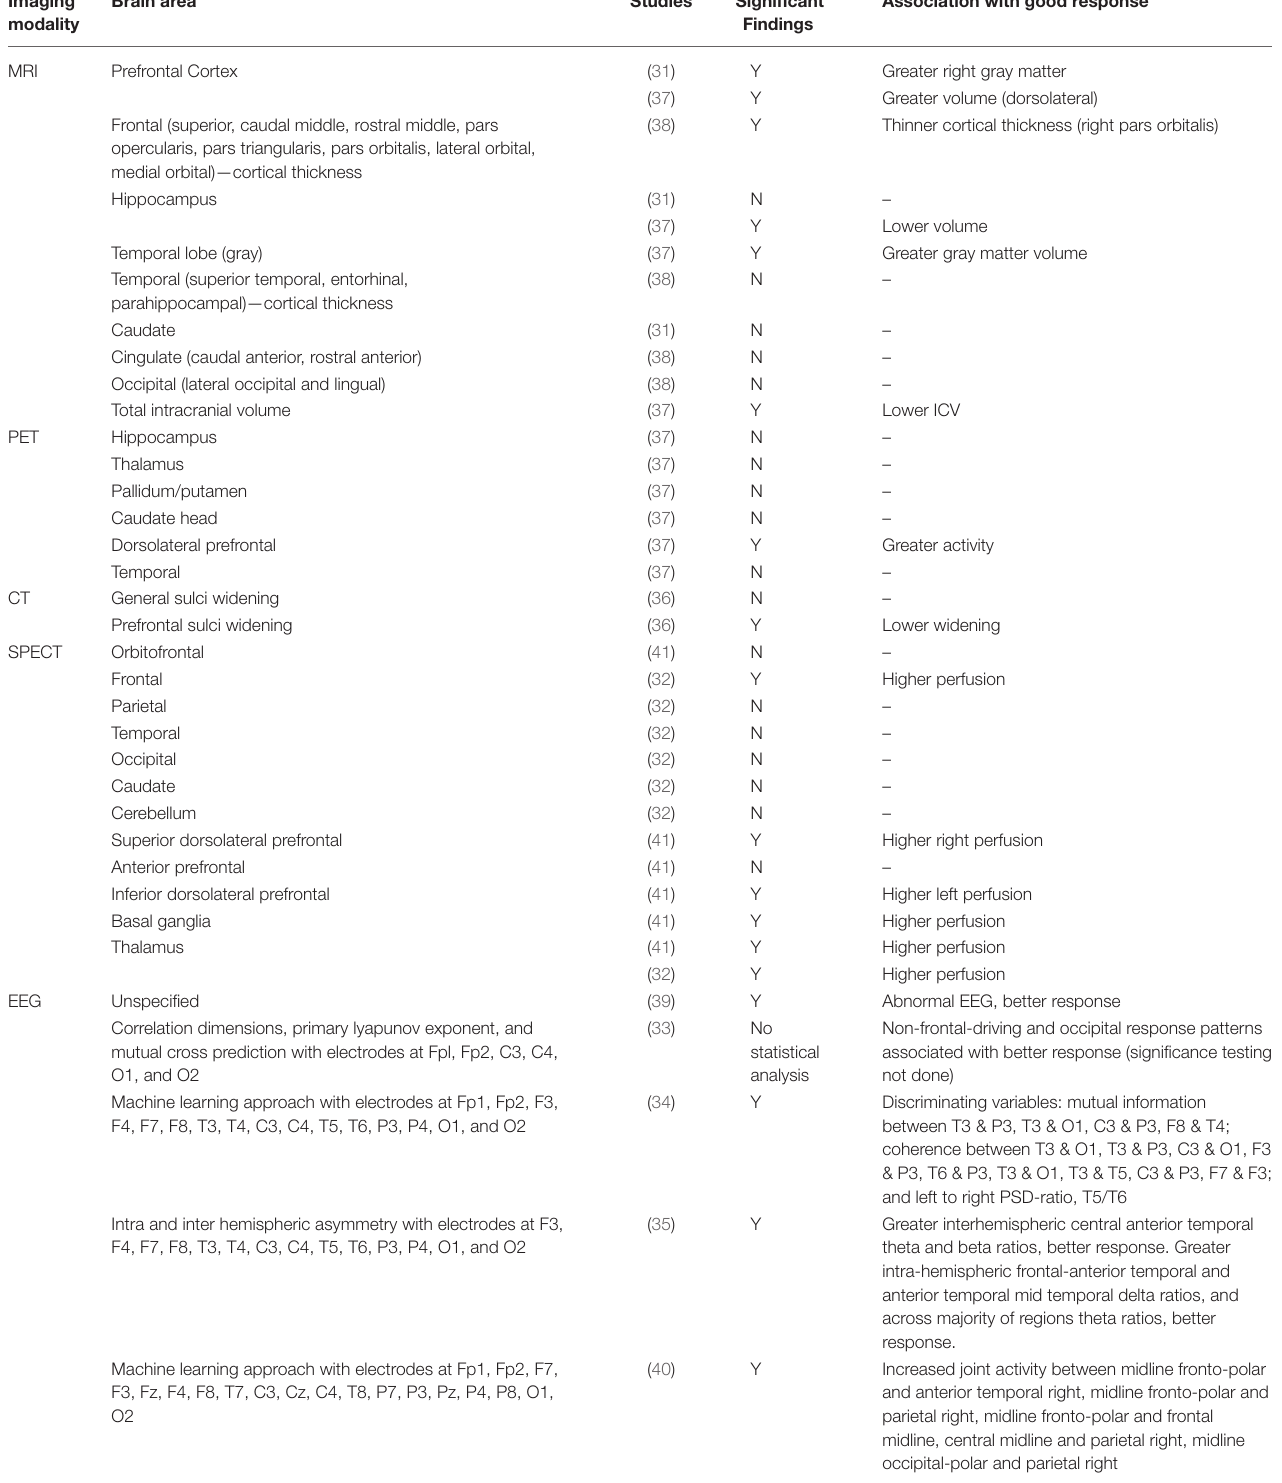
CT, Computerized Tomography; EEG, Electroencephalography; MRI, Magnetic Resonance Imaging; PET, Positron Emission Tomography; SPECT, Single-Photon Emission Computed Tomography.